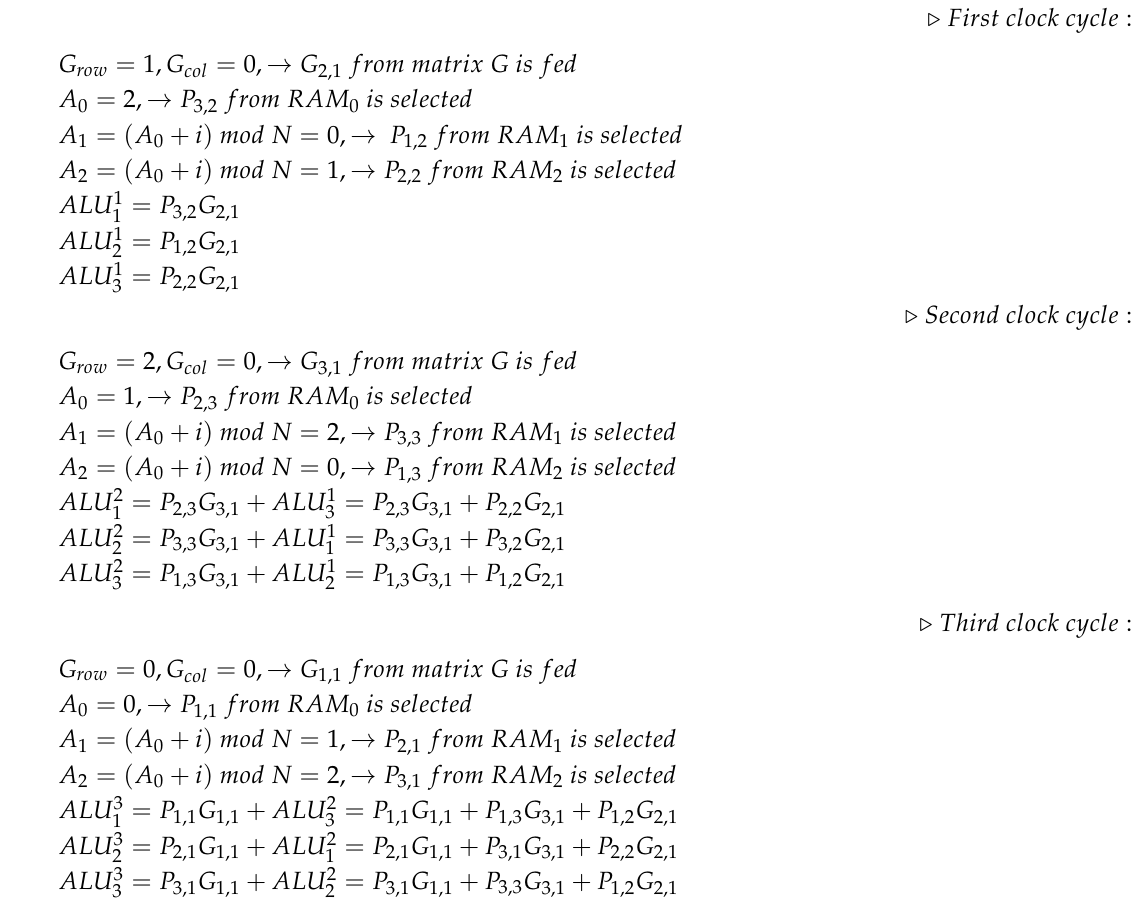
Algorithm 1 Sequence of operations for 3 × 3 matrix multiplication ( N = 3). By using concurrent arithmetic operations, one column result can be obtained after three clock cycles (Ncycles for the general case). The complete computation result is achieved in N 2 cycles for N × N